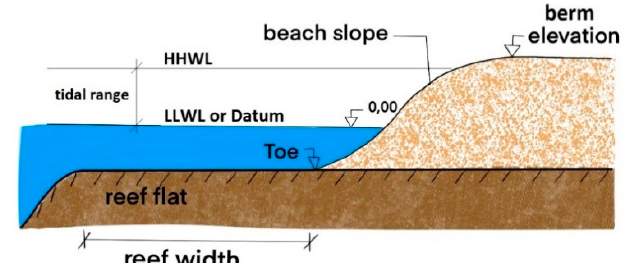
Figure 3. Sketch clarifying different morphological terms used in the text. LLWL refers to the lowest low water level.